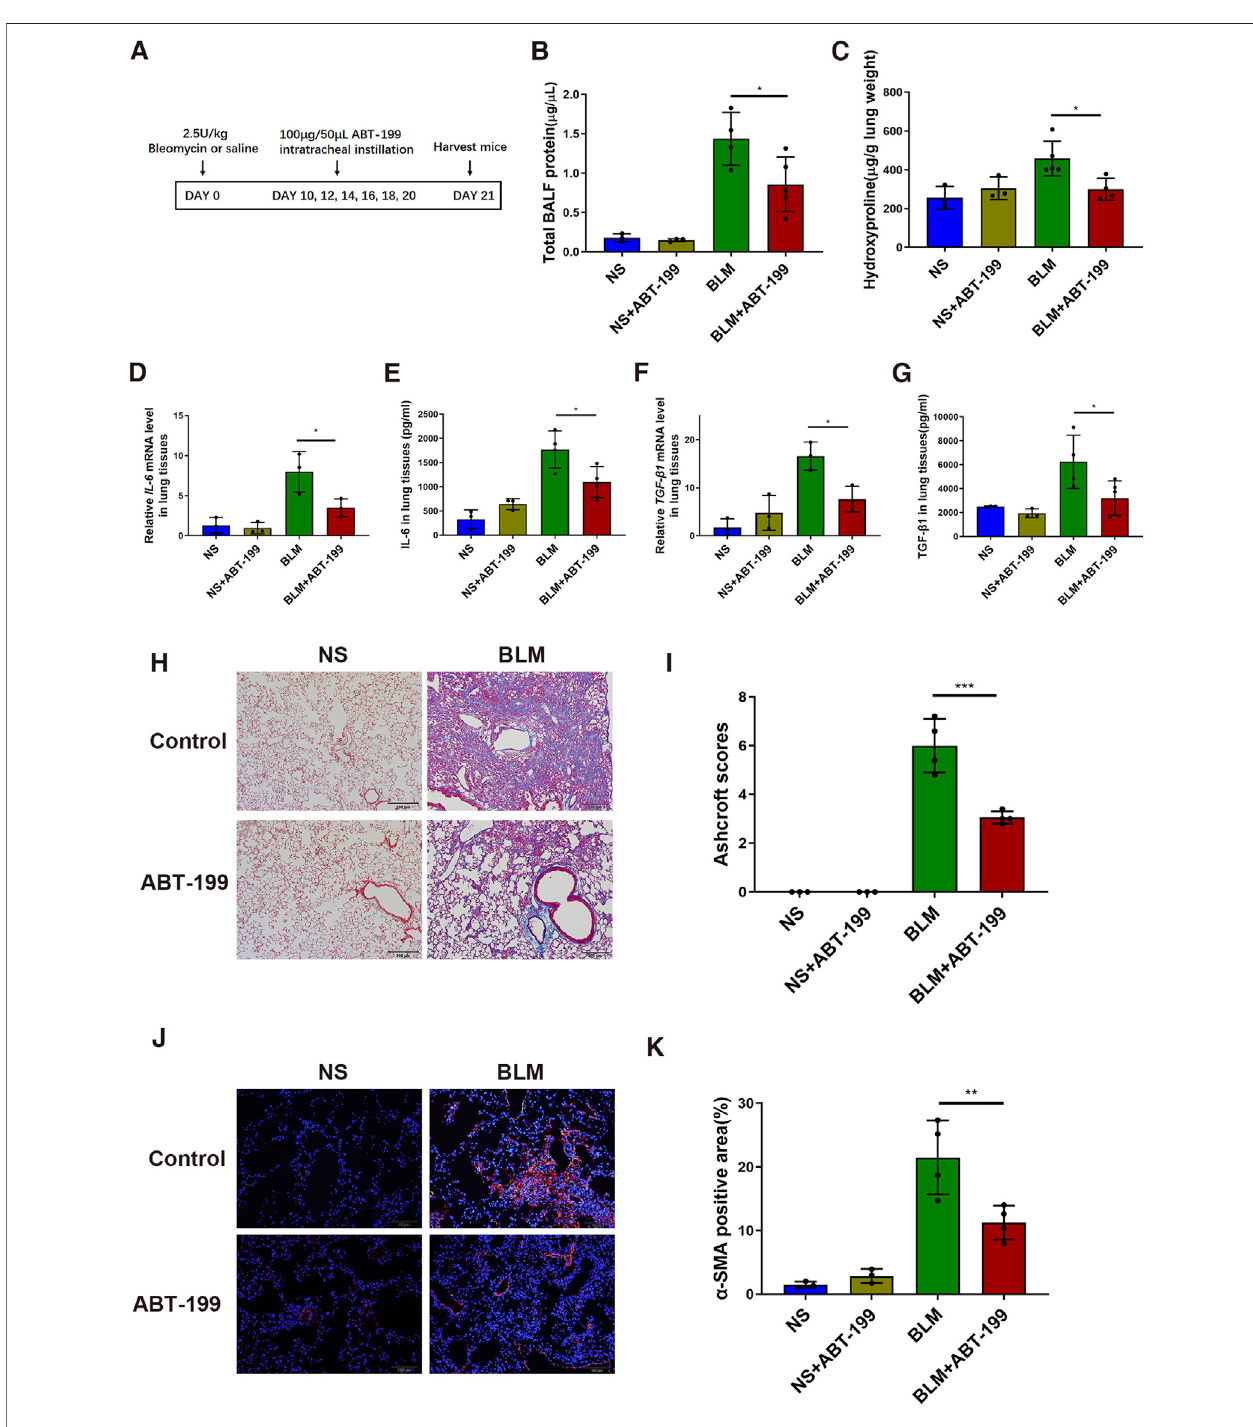
FIGURE 5 | ABT-199 reverses the established lung fi brosis in BLM-injured mice. (A) Treatment scheme. (B) Total BALF protein was measured using BCA Protein Assay. (C) Hydroxyprolinecontentsinlungtissues. (D , E) ExpressionlevelofIL-6inthelungtissuewasdeterminedusingreal-timePCRandELISA. (F , G) Expressionlevel of TGF- β 1 in the lung tissue was determined using real-time PCR and ELISA. (H) Representative images of lung sections stained with Masson ’ s trichrome. (I) The area analysisof fi broticchangesaccordingtoAshcroftscale. (J) Representativeimagesofmyo fi broblastsinlungtissuesbyimmuno fl uorescencestainingof α -SMA. (K) Quantitative analysis of α -SMA positive areas in lung sections. The data are presented as means ± SD of an experiment performed three times. * p < 0.05, ** p < 0.01, *** p < 0.001. n (cid:2) 3 – 6. BLM, bleomycin; Bcl-2, B-cell lymphoma-2; BAL, bronchial alveolar lavage; NS, normal saline; TGF- β 1, transforming growth factor- β 1; IL-6,